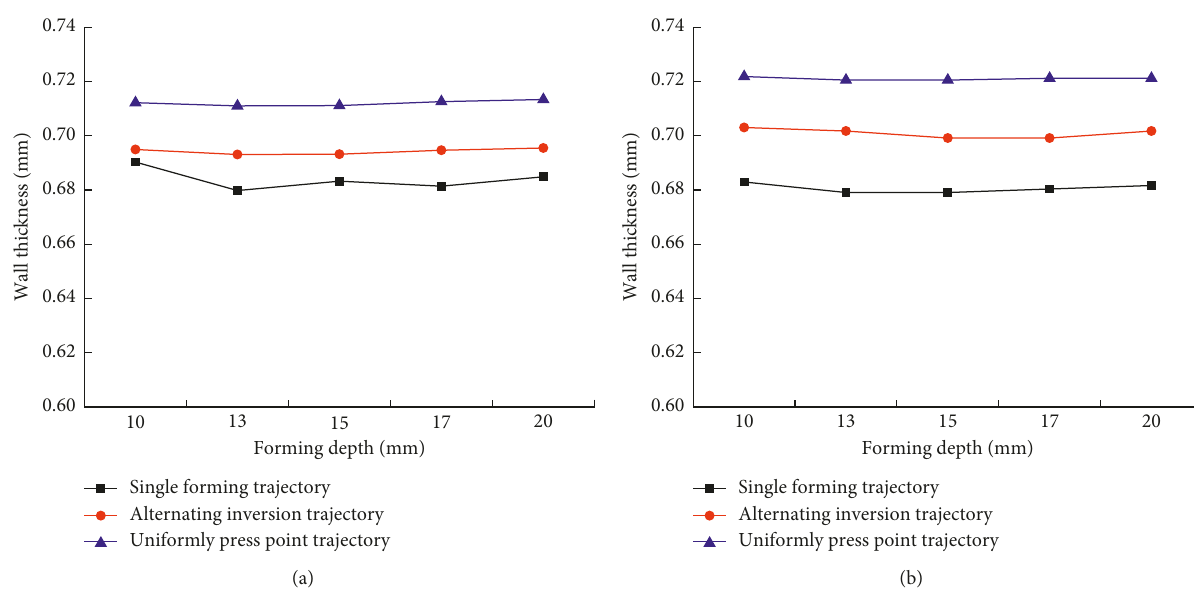
Figure 16: Thickness under three different forming trajectories. (a) Simulation results of the wall thickness and (b) experimental results of the wall